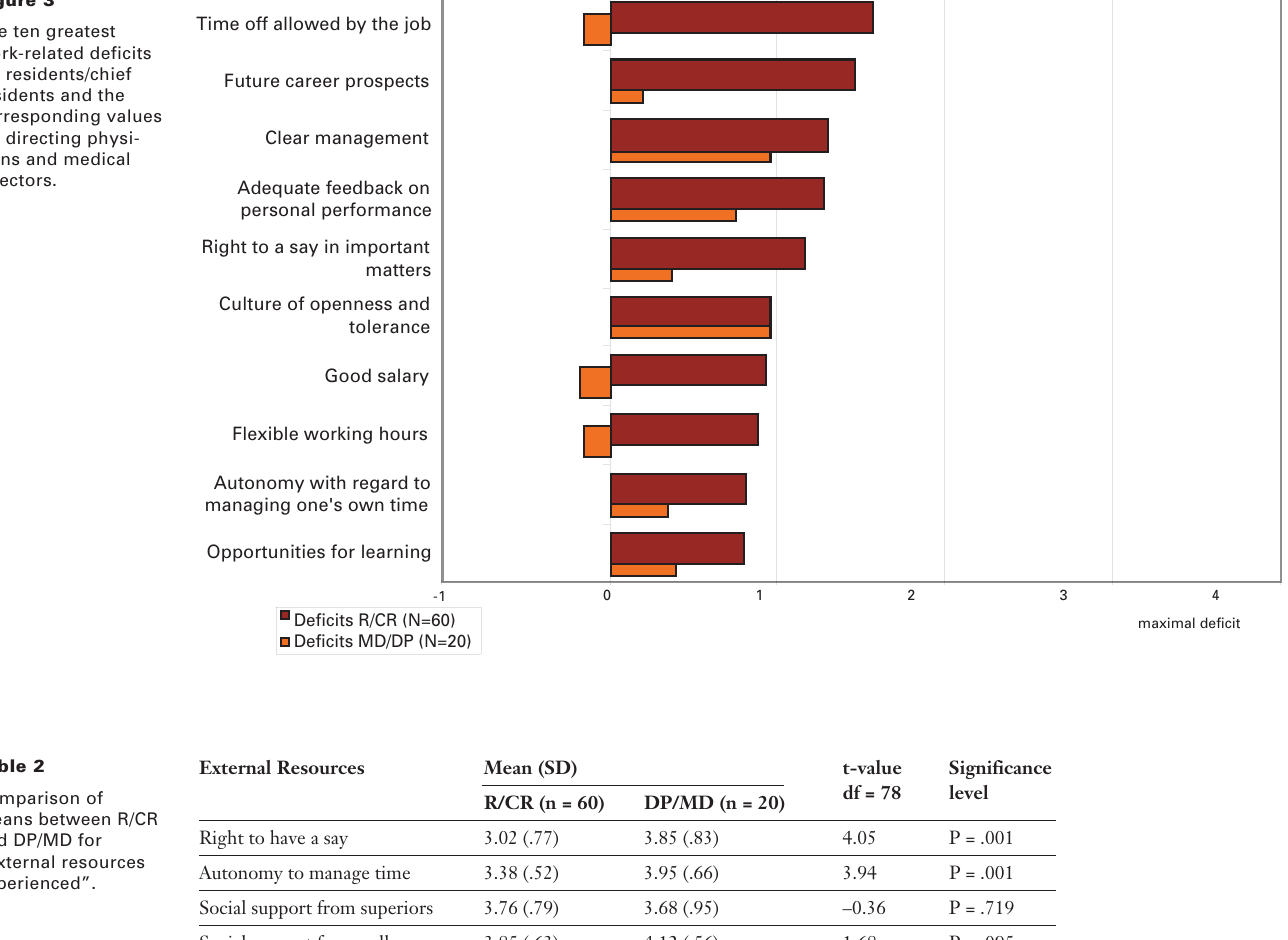
Figure 3 The ten greatest work-related deficits for residents/chief residents and the corresponding values for directing physi- cians and medical directors.